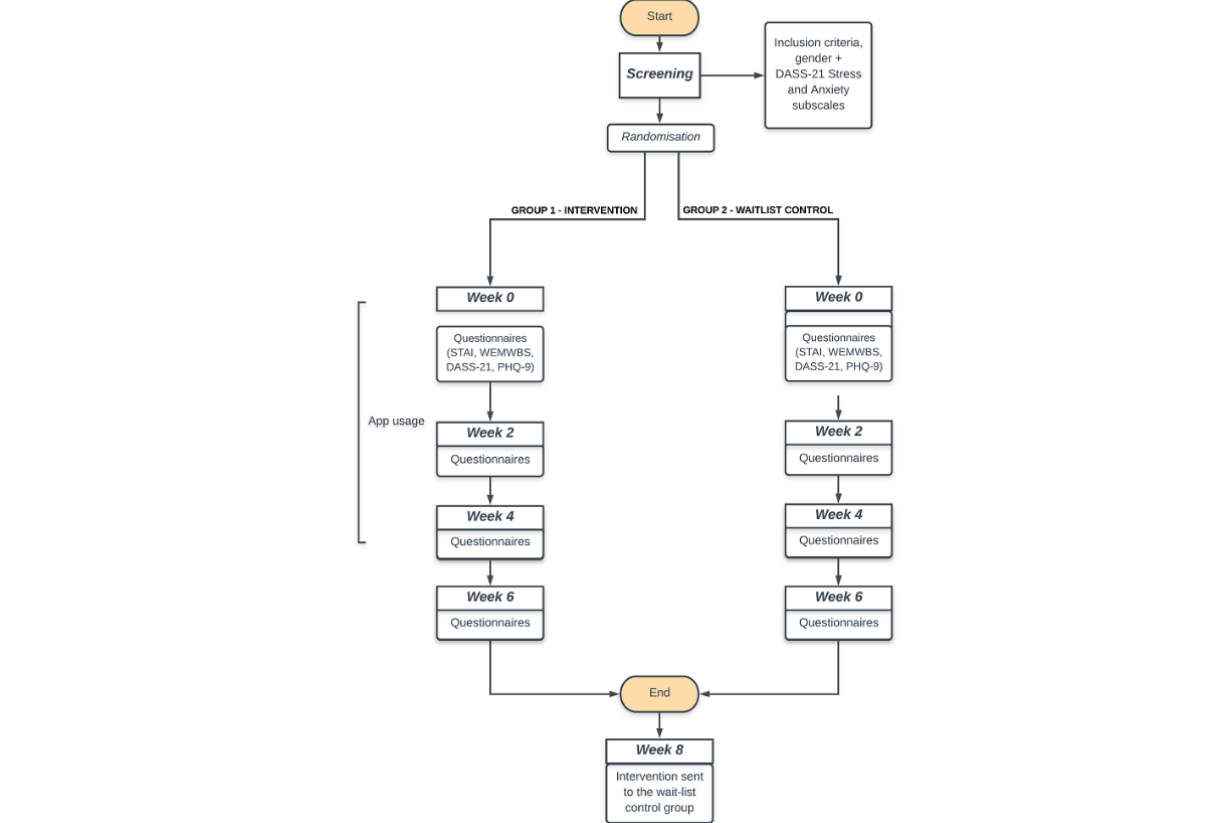
Figure 1. Timeline of the study. Participants were screened for inclusion and exclusion criteria. Of the 805 participants screened, only 262 were eligible to take part. These selected participants were subsequently randomly assigned to one of two groups: intervention or wait-list control. Each group received the questionnaires at baseline, 2, 4 and 6 weeks. The intervention group received access to the program following the first questionnaire